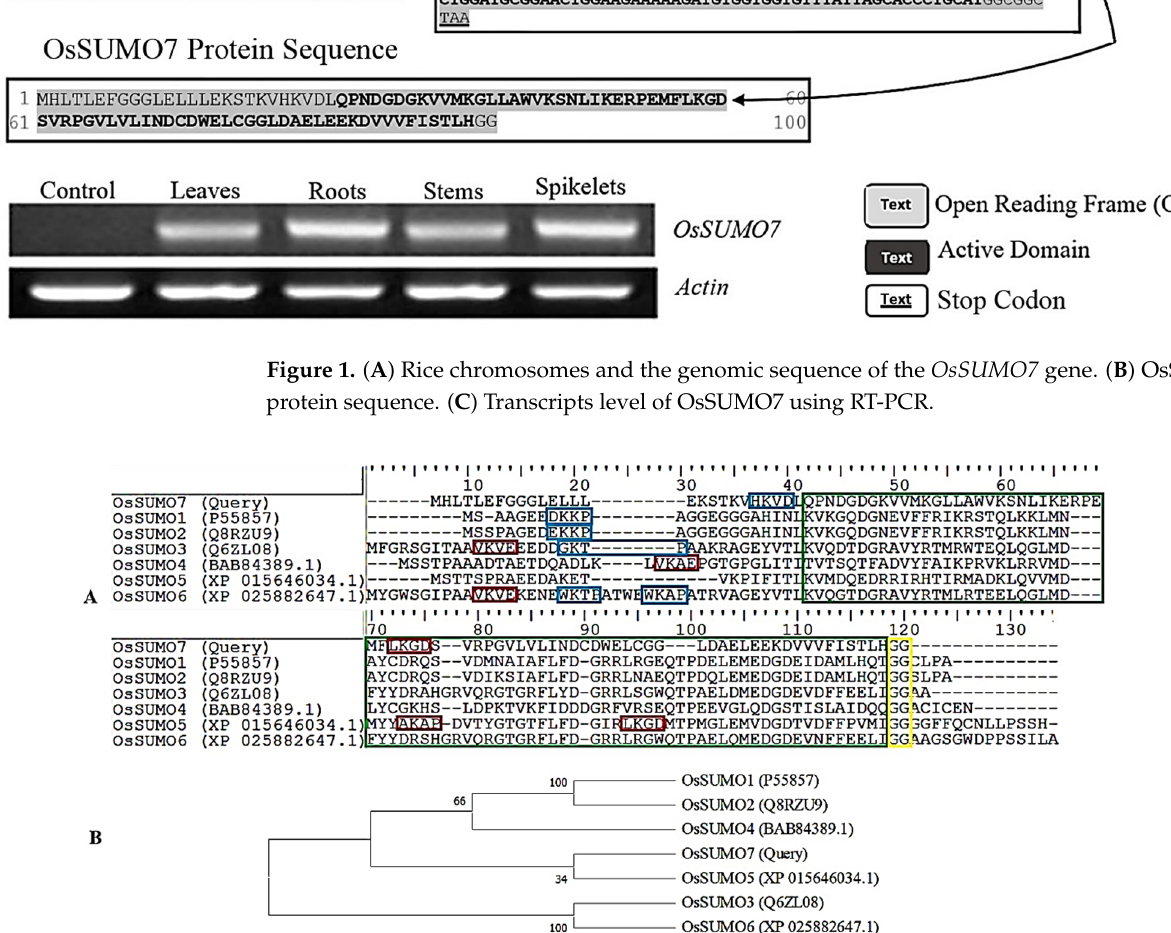
Figure 2. ( A ) Alignment of SUMO genes in rice . Di-glycine motifs at the end of the mature SUMO proteins are indicated by the yellow box. Potential SUMOylation sites ( Ψ KXE/D) are boxed in red for a high probability and with blue for a low probability. A green box refers to the conserved ubiquitin-like domain. ( B ) Phylogenetic tree analysis of the OsSUMO family.